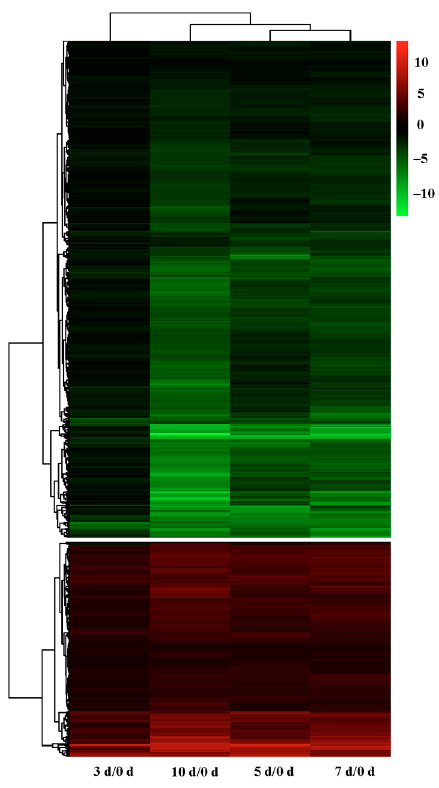
Figure 8. Hierarchical cluster analysis of 1243 common differentially expressed genes in G. anomalum under drought stress. The up-regulated genes are marked in red, while down-regulated genes are marked in green. The DEGs of 3 d-treated sample are divided in a separate group, while 5 d samples are grouped closely with those in at 7 d and 10